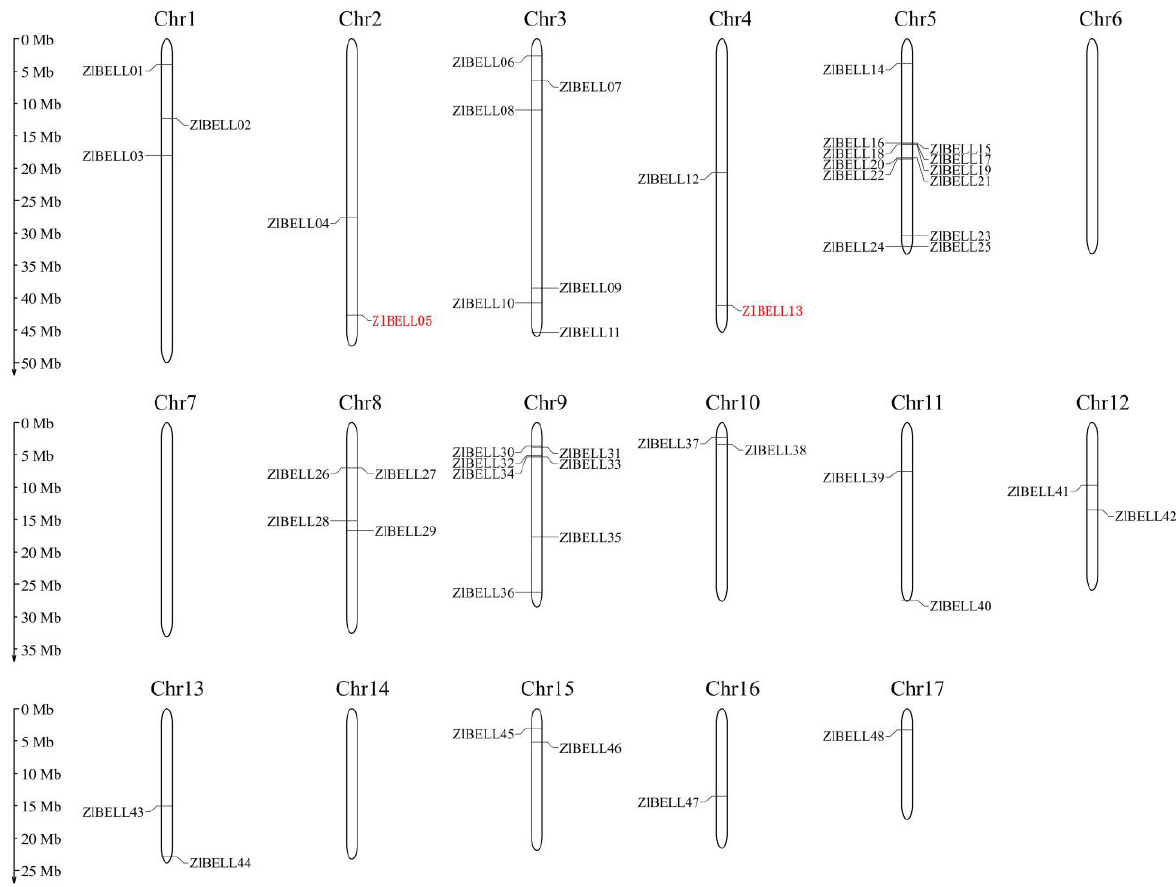
Figure 1. Chromosomal locations of BELL genes in Zizania latifolia . The gene IDs of the ZlBELL family are listed in Table S1. ZlBELL05 (ZlqSH1b) and ZlBELL13 (ZlqSH1a) are marked in red.